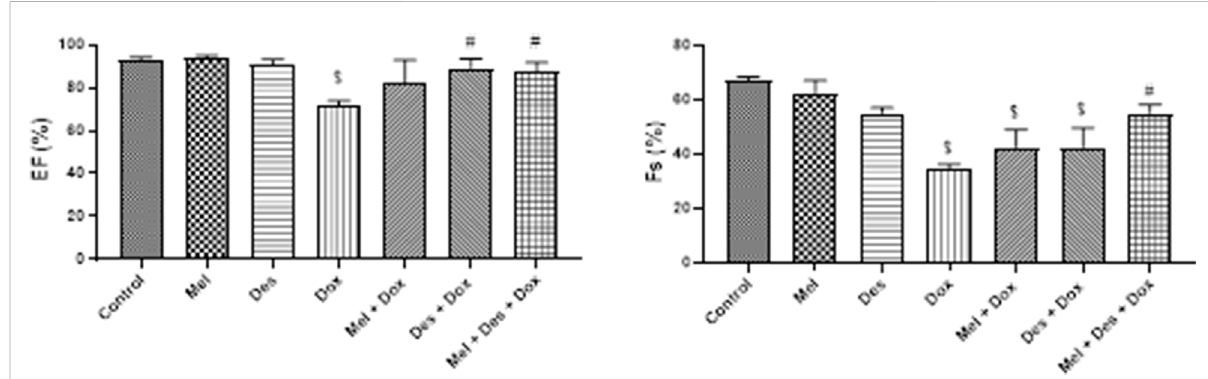
FIGURE 7 Graphs showing the results of ejection fraction and fractional shortening. $: signi fi cant versus control, #: signi fi cant versus Dox, @: signi fi cant versus Mel-Dox, *: signi fi cant versus Des-Dox. Mel: melatonin; Des: deferoxamine; Dox: